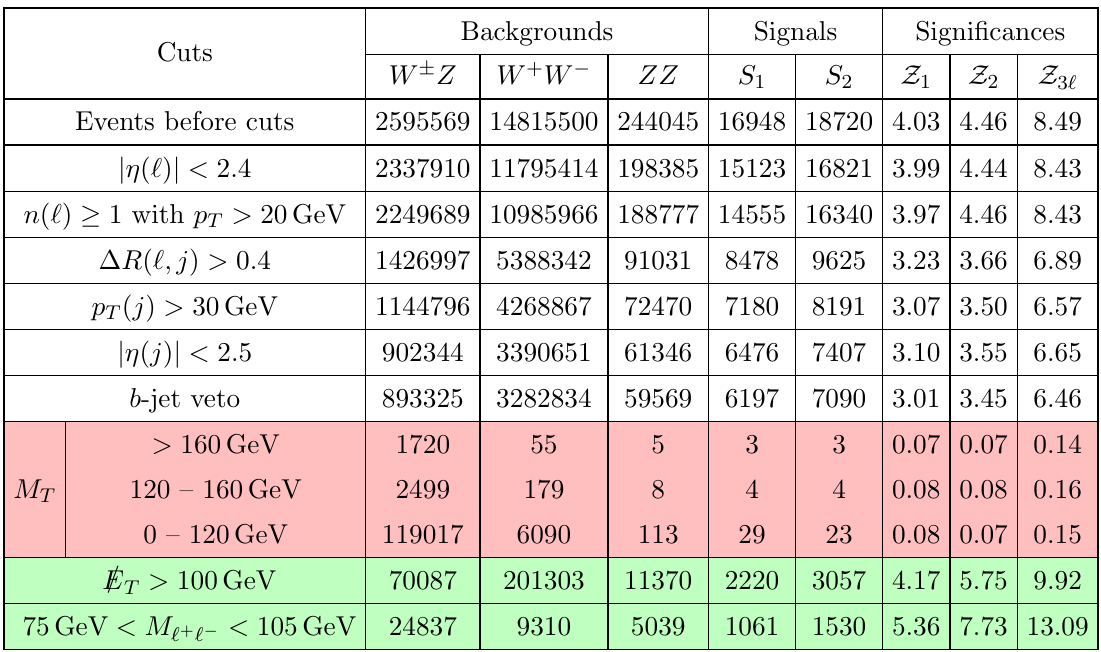
Table 4. As in table 3 above, for L = 1000 fb (cid:0) 1